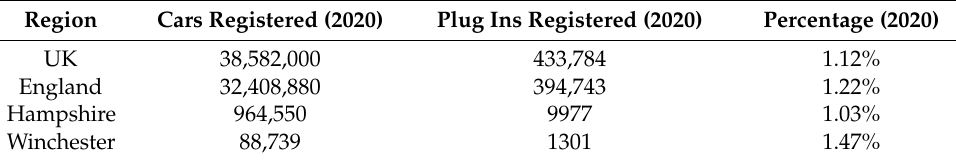
Table 1. Registered cars and plug in cars adopted from [8–10].